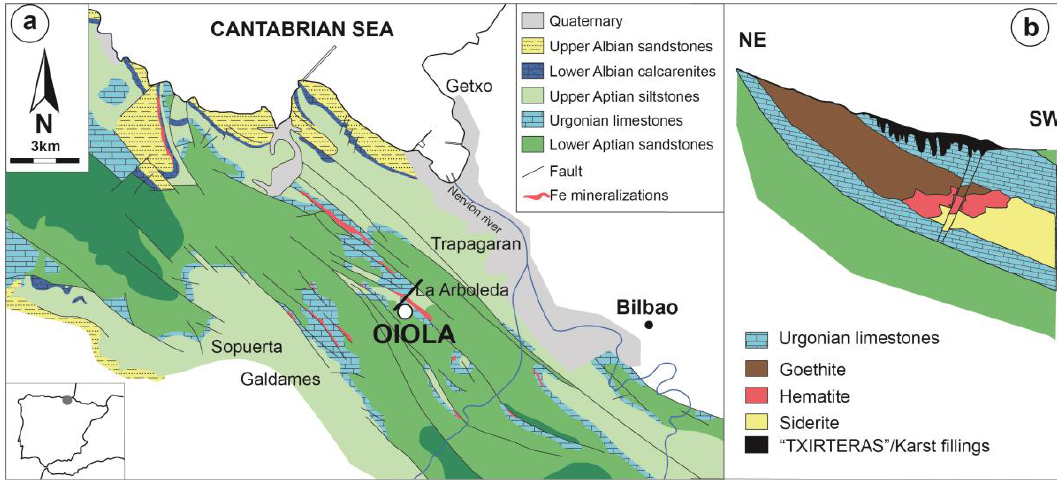
Figure 1. ( a ) Geographical location and geological setting of Oiola archaeological site; ( b ) scheme of the type of mineralization the iron oxyhydroxides (modified from